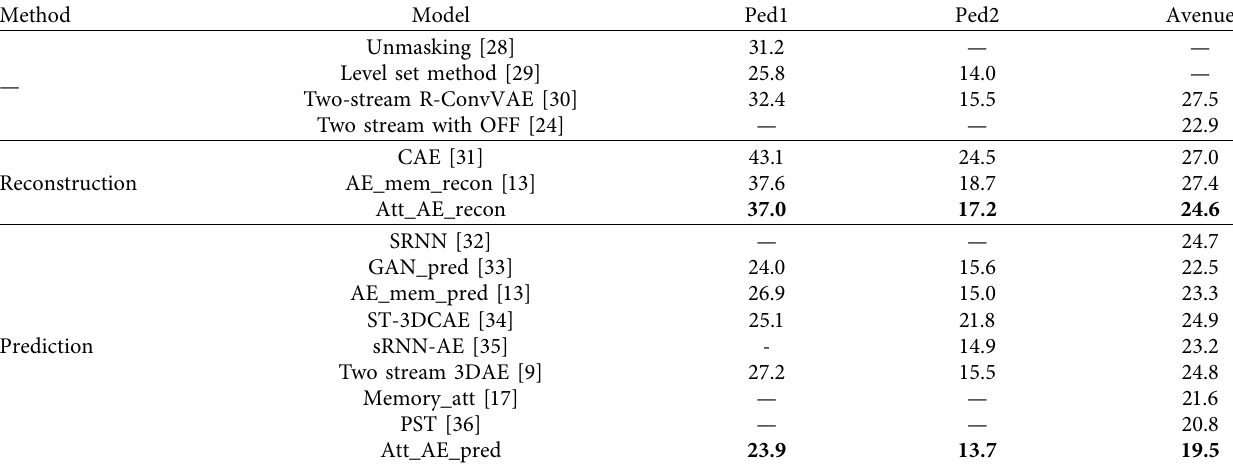
Table 4: Comparative experiments of the attention-directed abnormal behavior detection model (EER%).